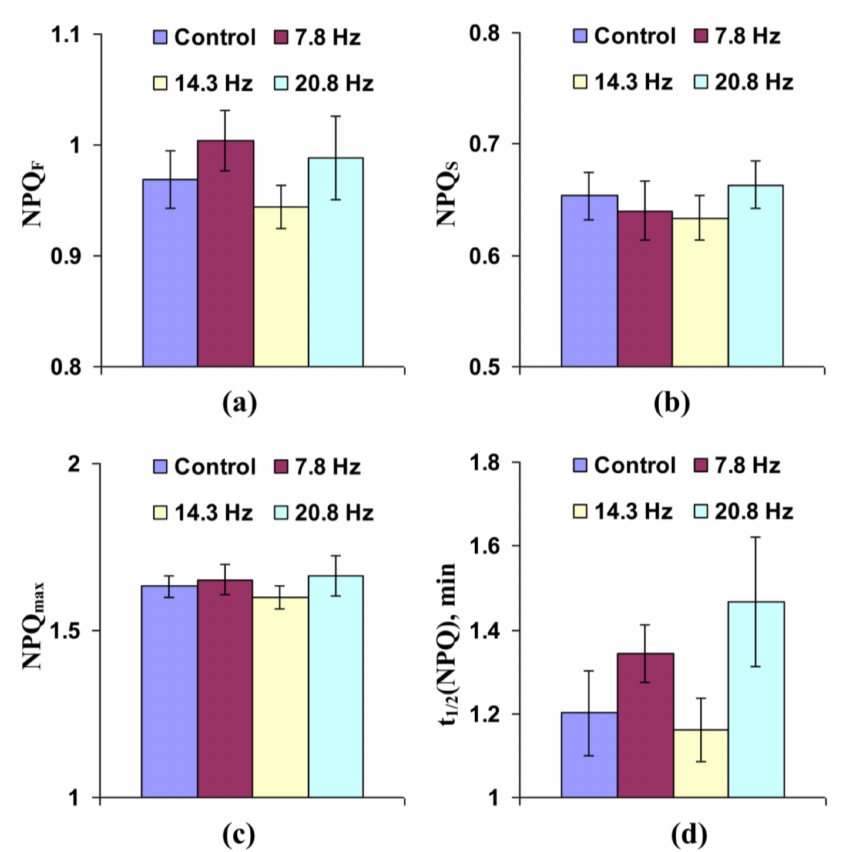
Figure 6. Influence of short-term treatment by artificial extremely low frequency magnetic field on fast-relaxing component of non-photochemical quenching under illumination (NPQ F ) ( a ), slow- relaxing component of non-photochemical quenching after this illumination (NPQ S ) ( b ), maximal value of non-photochemical quenching (NPQ max ) ( c ), and time taken for 50% increase of NPQ under illumination (t 1/2 (NPQ)) ( d ) in pea seedlings ( n = 9). Action of the artificial magnetic field was immediately initiated before dark adaptation; total duration of its action was 30 min. Photosynthetic parameters were measured by the action of this field. Magnitude of the magnetic fields was 18 µ T; frequencies were 7.8, 14.3, and 20.8 Hz. Control plants were not treated by this artificial magnetic field. Significant differences between the experiment and control plants were